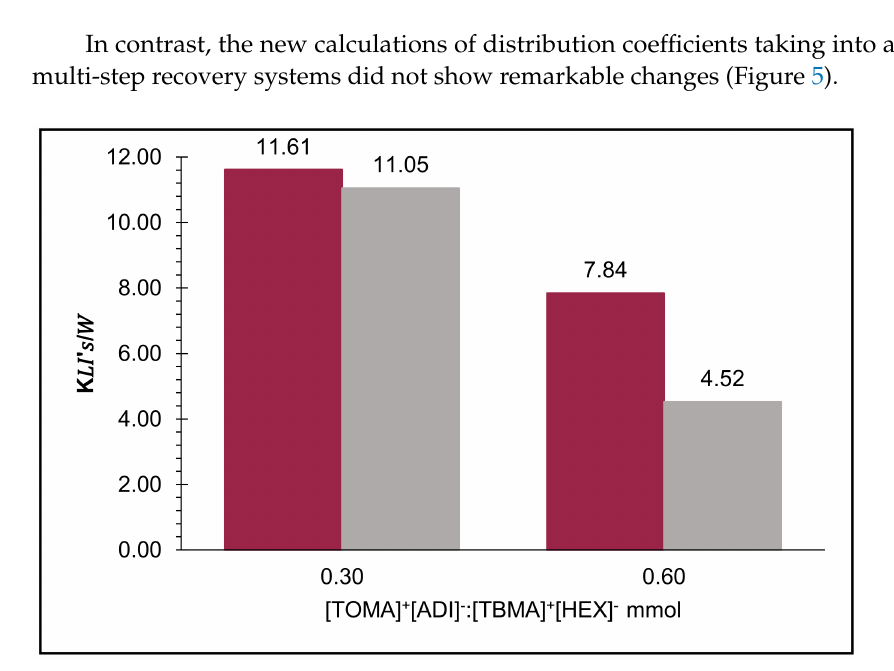
Figure 5. Distribution coefficients after two steps (1st step—red color, 2nd step—grey